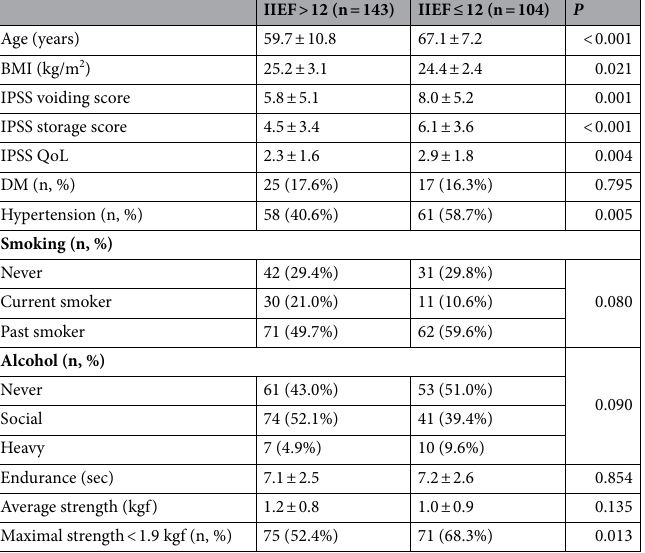
Univariate logistic regression